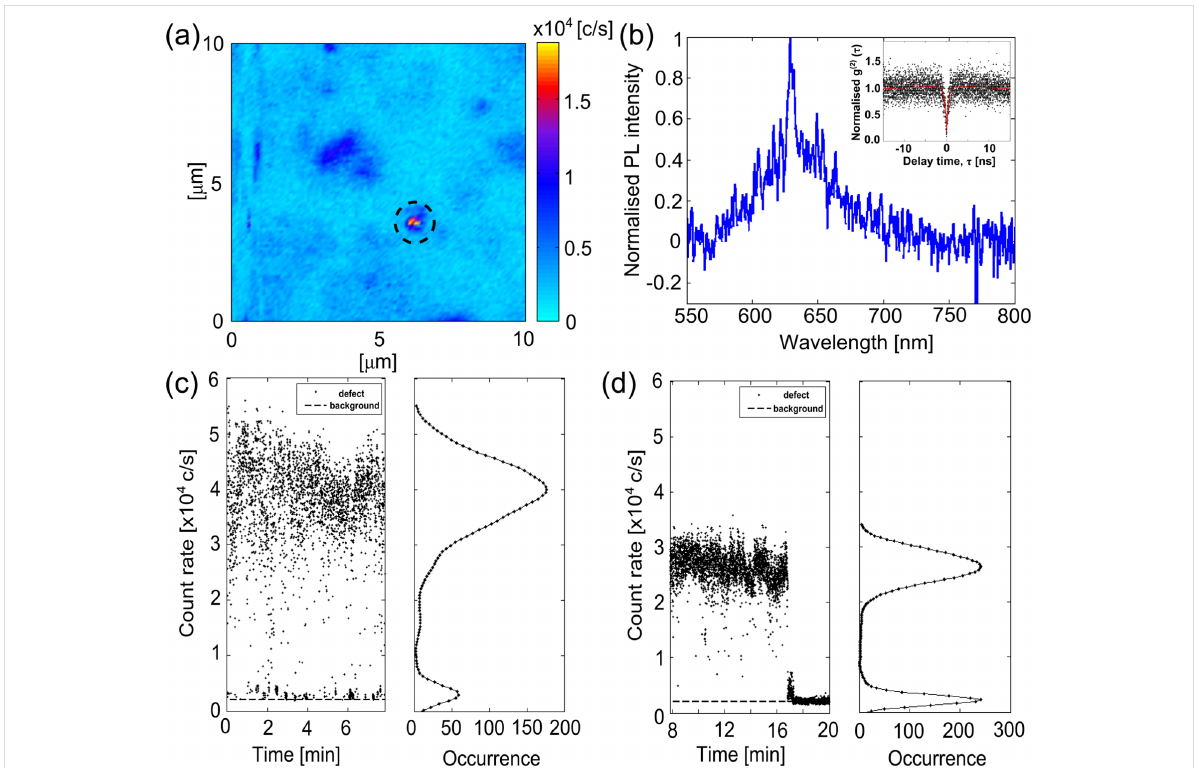
Figure 6: Characterisation results of a defect found in the sample of TiO 2 anatase nanopowder and IPA. (a) 10 × 10 μ m 2 confocal scan indicating the defect with a dashed circle. The colour bar represents the count rate at the detector. (b) Normalised PL spectrum with an inset of a three-level model fit (red line) of the normalised g (2) data (black points). The fit parameters had count rates of 25.0 × 10 3 c/s and 24.5 × 10 3 c/s at each detector, a back- ground count rate of 2 × 10 3 c/s and integration time of 1200 s. (c, d) Count traces and histograms of the single-photon emitter for two periods of time (0–8 min and 8–20 min, respectively). The histograms in (c) and (d) were binned into 982 c/s and 505 c/s, respectively. The background count rate is indicated by the dashed line. The pump power for the results in panels b–d was 41.9 ± 0.1 μ